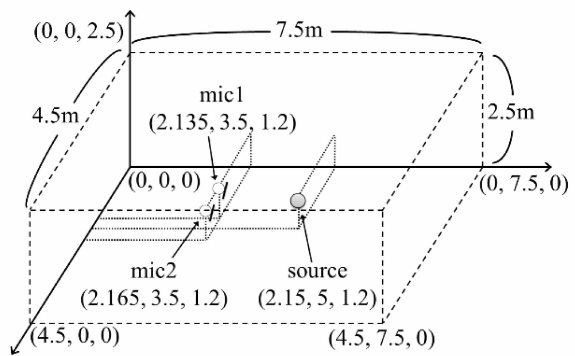
Figure 7. Experimental setup for simulating the room impulse response to simulate a reverberant environment.